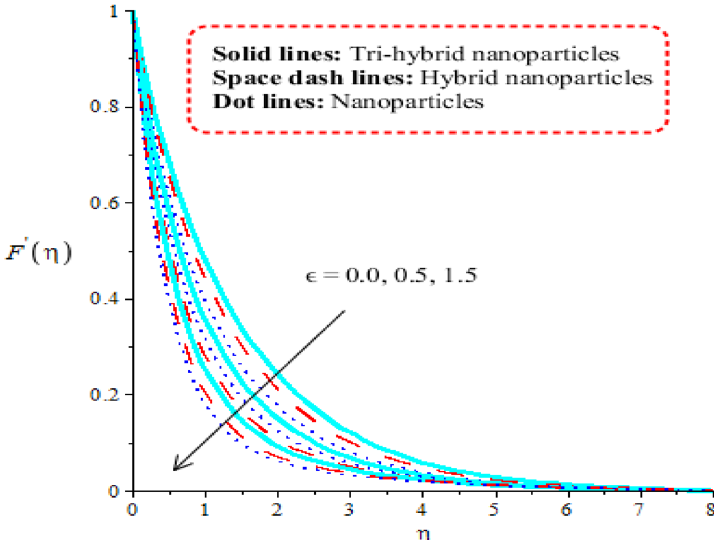
Figure 3. Distribution in F ′ (η) against ǫ .